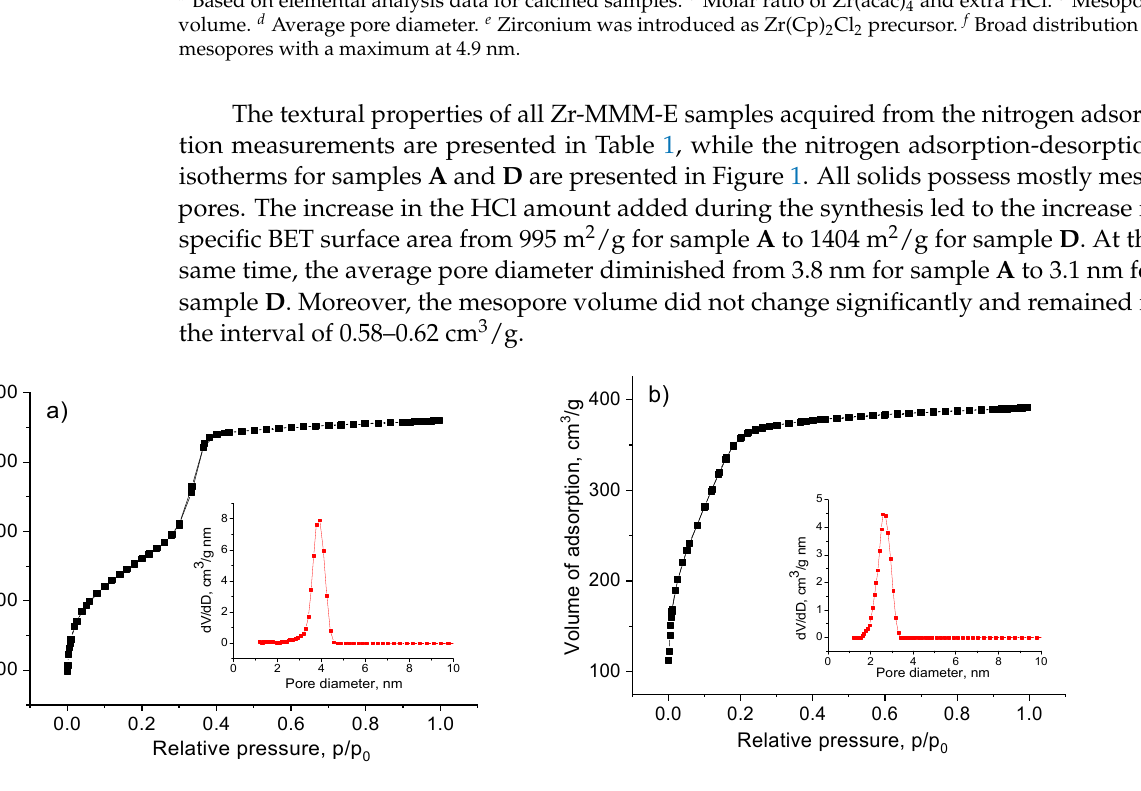
Figure 1. Nitrogen adsorption–desorption isotherm and pore size distribution (inset) for Zr-EISA ( a ) sample A and ( b ) sample D .